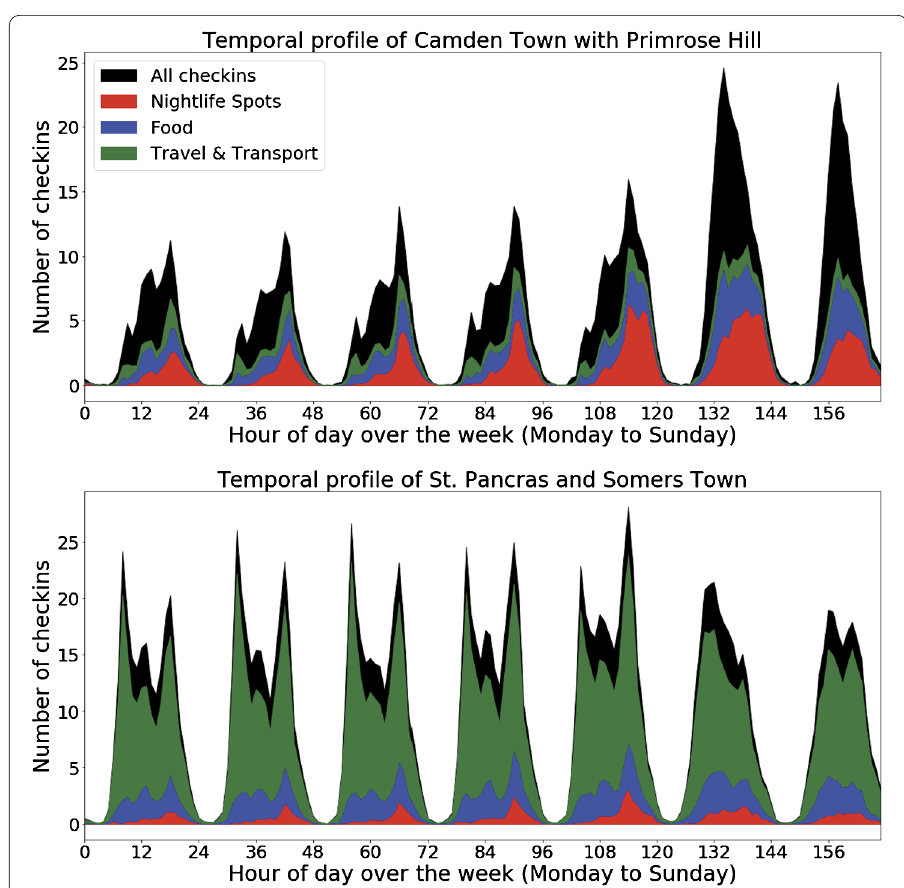
Figure 3 Ward temporal profile. Daily temporal profiles and category breakdown of St. Pancras & Somers Town and Camden Town with Primrose Hill, two contrasting wards in